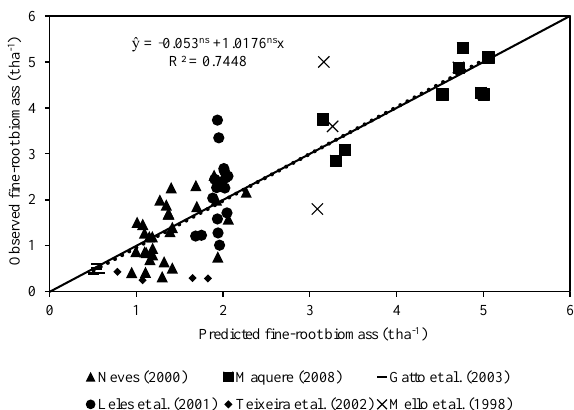
Figure 3. Regression of fine-root biomass reported in the literature against values predicted using the ForPRAN model. The dotted line is the mean regression, with neither intercept nor slope significantly different from 0 or 1, respectively. Solid line: 1:1 relationship.